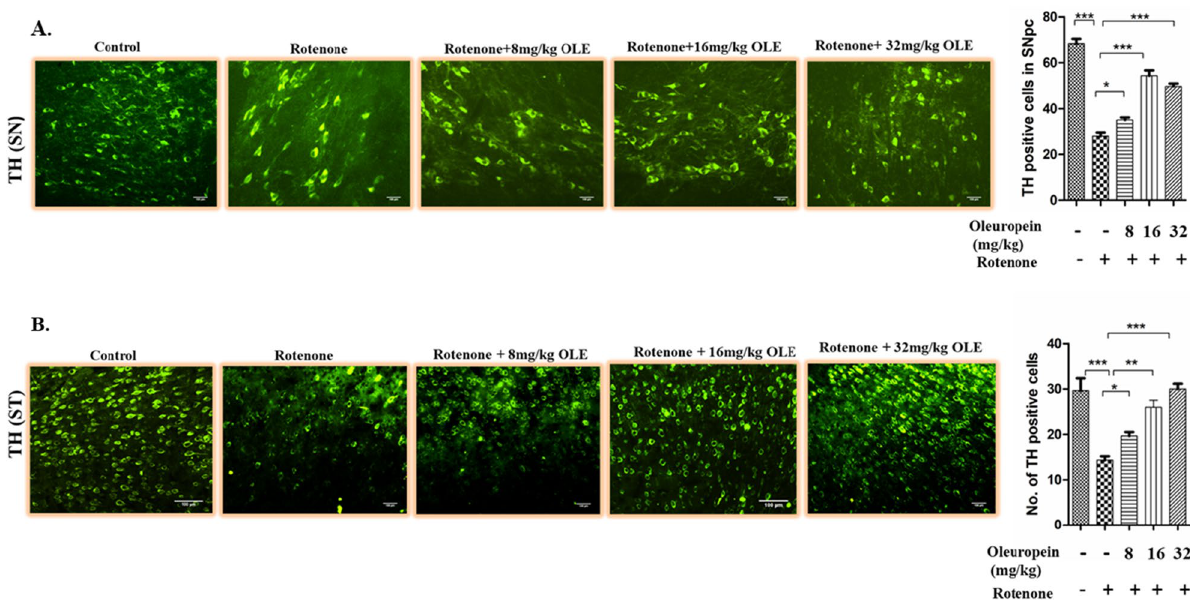
Figure 3. The immunoreactivity of TH in the SN and ST of various experimental groups was examined using immunohistochemistry under the florescence microscope (20×). Rotenone intoxicated group showed less immunoreactivity than control (p < 0.001) in SN and ST. While, increased immunoreactivity of TH was observed in case of OLE treated group (16 and 32 mg/kg bwt) in SN (p < 0.001) and ST (p < 0.01). In all these three biochemical parameters, the OLE doses of 8 mg/kg bwt. showed a less significant effect. (*p < 0.05). Values are expressed as mean ± SEM (n = 6). ***p < 0.001, and *p < 0.05. SEM Standard error of mean, OLE Oleuropein, SN Substantia nigra, TH Tyrosine